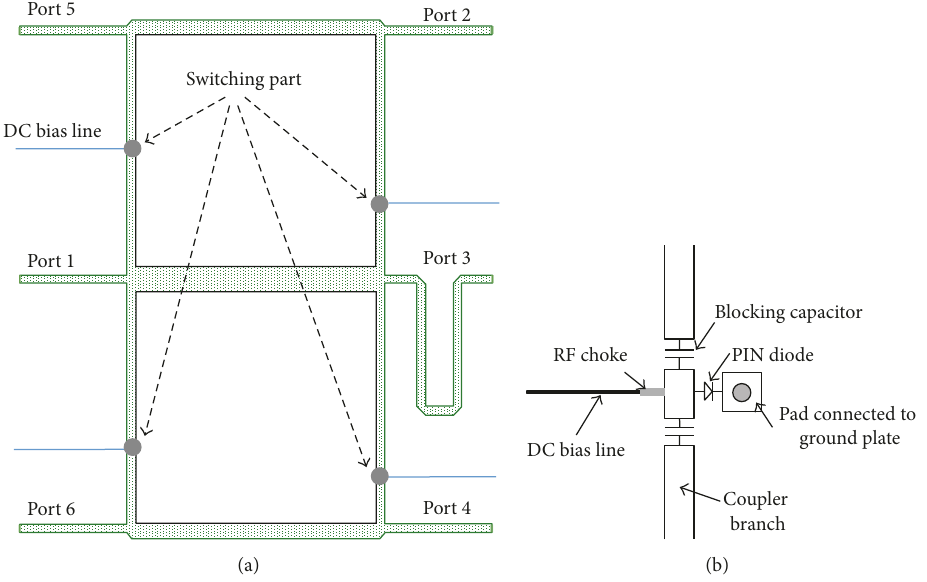
Figure 11: Schematic diagram of coupler using PIN diode and DC bias line: (a) whole structure and (b) switching part with PIN diode.